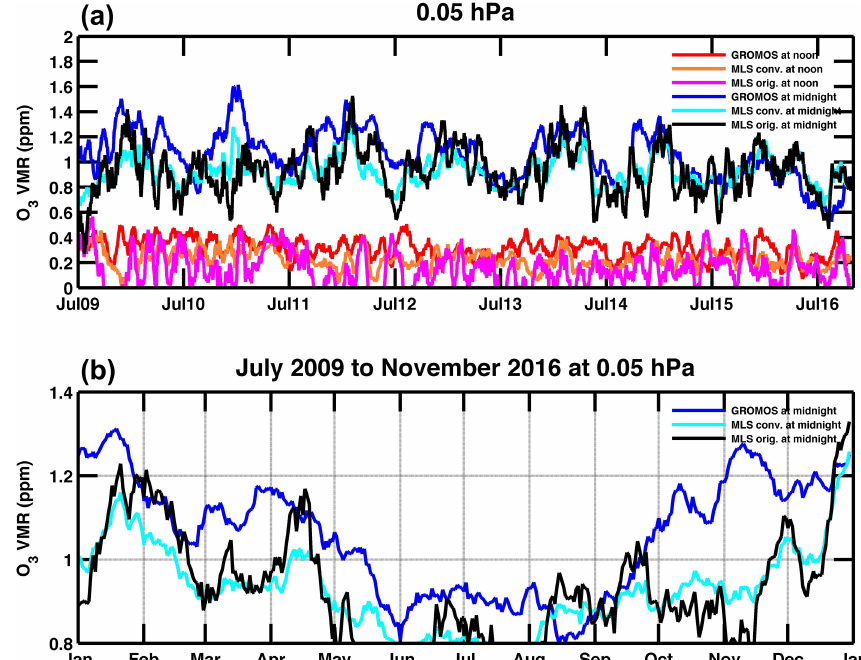
Figure 6. Panel (a) shows the diurnal variation in O 3 VMR measured at noon (GROMOS in red, MLS convolved in orange, and MLS original in magenta) and at midnight (GROMOS in blue, MLS convolved in cyan, and MLS original in black) at 0.05hPa (70km), and panel (b) shows its evolution throughout the year averaged for the time interval under assessment (July 2009–November 2016). All time series are smoothed in time by a moving average over 15 points ( ∼ 1